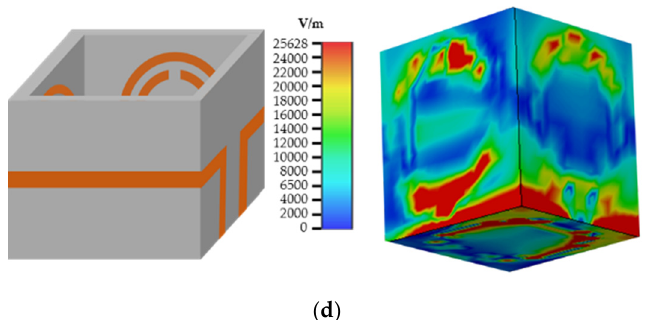
Figure 7. The electric field distribution: ( a ) without a microstrip line and SRR; ( b ) only microstrip lines loaded; ( c ) only SRR loaded; ( d ) microstrip line and SRR loaded.